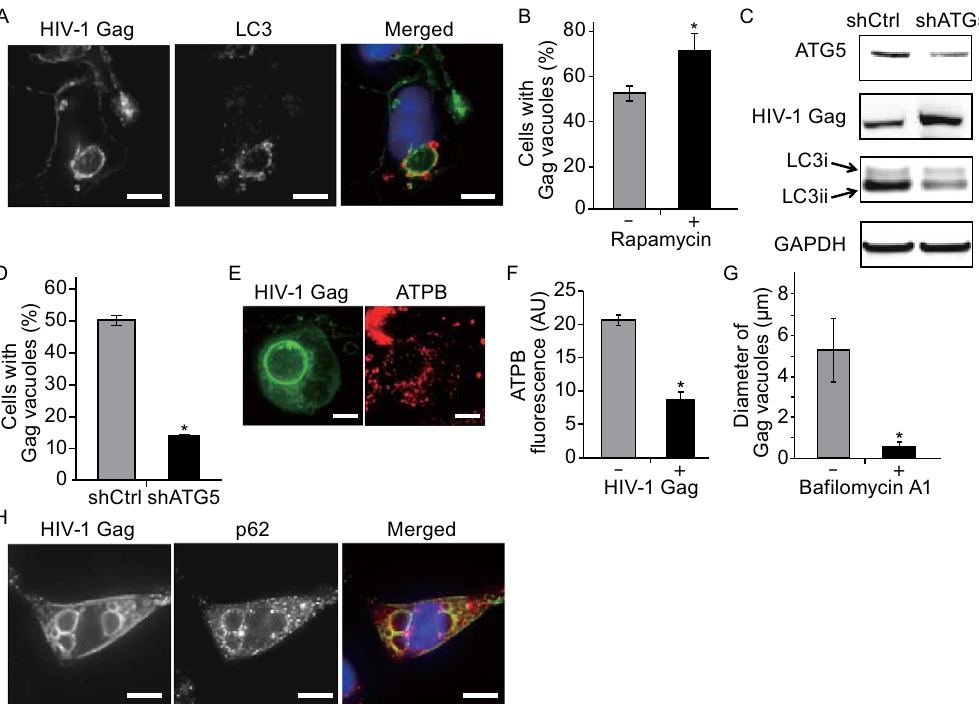
Figure 3. The role of autophagy in mediating lysosomal delivery of misassembled viral complexes. (A) Representative images of LC3 and HIV-1 Gag in MiR + cells. LC3 and HIV-1 Gag colocalize at the vacuoles. (B) Increase in Gag vacuole formation in response to rapamycin treatment. 24 h after MiR + cells were transfected with pNL43 Δ P Δ E-Gag-EGFP constructs, rapamycin (200 nmol/L) or DMSO control were added. Percentage of Gag-expressing MiR + cells containing at least one vacuole were assayed by fl uorescence microscopy at 24 h following treatment. (C) The effect of ATG5 knockdown on HIV-1 Gag and LC3 conversion using shRNA against ATG5 (shATG5). At 48 h post-transfection, Western blot was performed to assess knockdown ef fi ciency and its effect on Gag and LC3 conversion. shATG5 reduced the level of ATG5 by ∼ 40%. This reduction was accompanied by ∼ 50% reduction in LC3 conversion (calculated as the ratio of LC3ii to GAPDH) and a nearly two-fold increase in HIV-1 Gag accumulation in cells compared with cells transfected with the shCtrl plasmid. (D) Knockdown of ATG5 led to a reduction in Gag vacuole formation, assayed by fl uorescence microscopy. (E) MiR + cells expressing pNL43 Δ P Δ E-Gag-EGFP were fi xed and immuno fl uorescently-labeled with anti-ATPB antibodies to stain mitochondria. (F) Quanti fi cation of total mitochondrial ATPB signal per cell. (G) Decrease in Gag vacuole diameter in response to ba fi lomycin A1 treatment. 24 h after MiR + cells were transfected with pNL43 Δ P Δ E-Gag-EGFP constructs, 50 nmol/L ba fi lomycin A1 or DMSO control were added. Following 18 h incubation, cells were imaged for the presence of vacuoles. (H) Representative images of p62 and HIV-1 Gag in MiR + cells. p62 and HIV-1 Gag colocalize at the vacuoles. For (B) and (D), data represent mean ± SD of three replicates, with each replicative experiment performed by examining at least 200 transfected cells. For (F), data represent mean fl uorescence intensity ± SD of 50 cells either untransfected or transfected with pNL43 Δ P Δ E-Gag-EGFP. For (G), data represent mean diameter ± SD of at least 200 individual vacuoles. Scale bar = 10 μ